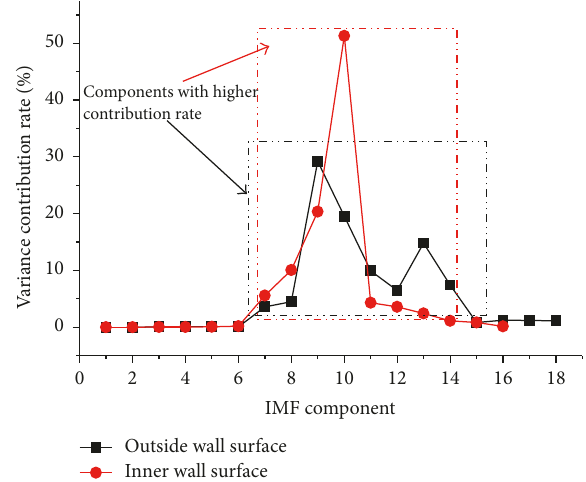
Figure 9: IMF components’ variance contribution rates of vibration velocity signals at inner and outer surfaces of explosive vessel shell.